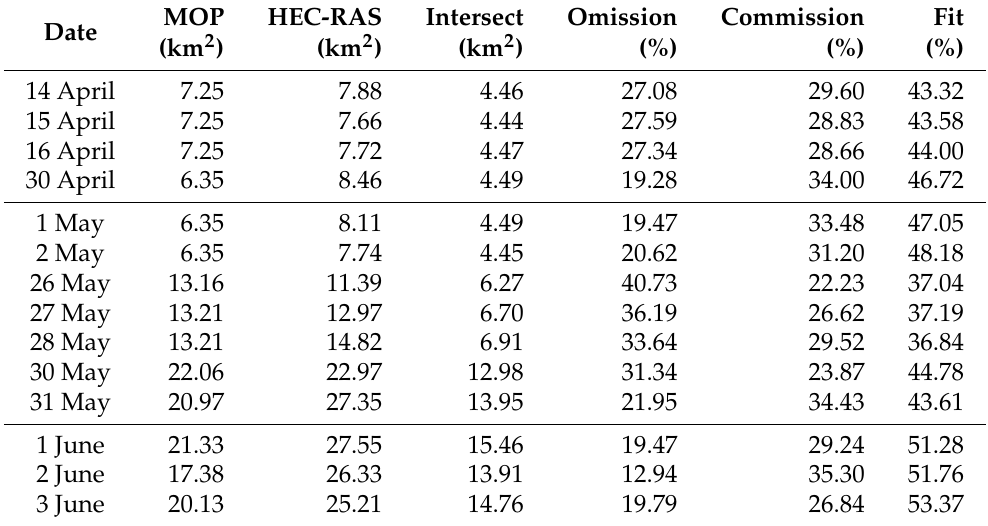
Figure 13. Areas of commission for all data combinations available for 1 June 2015. Table 2. Measure of fit, commission, and omission for each day that MOD and HEC-RAS are